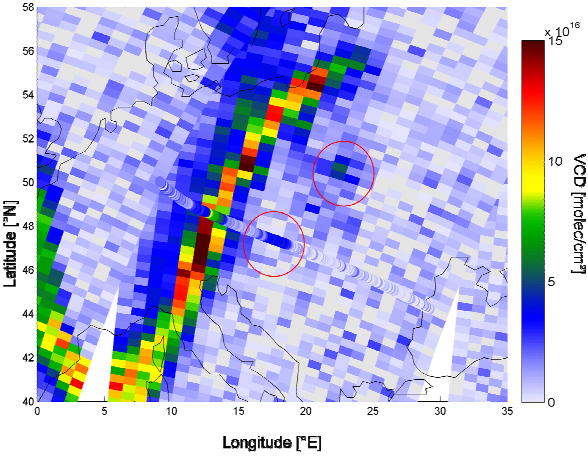
Fig. 9. GOME-2 and CARIBIC DOAS SO 2 vertical column den- sity. No time correction is applied.